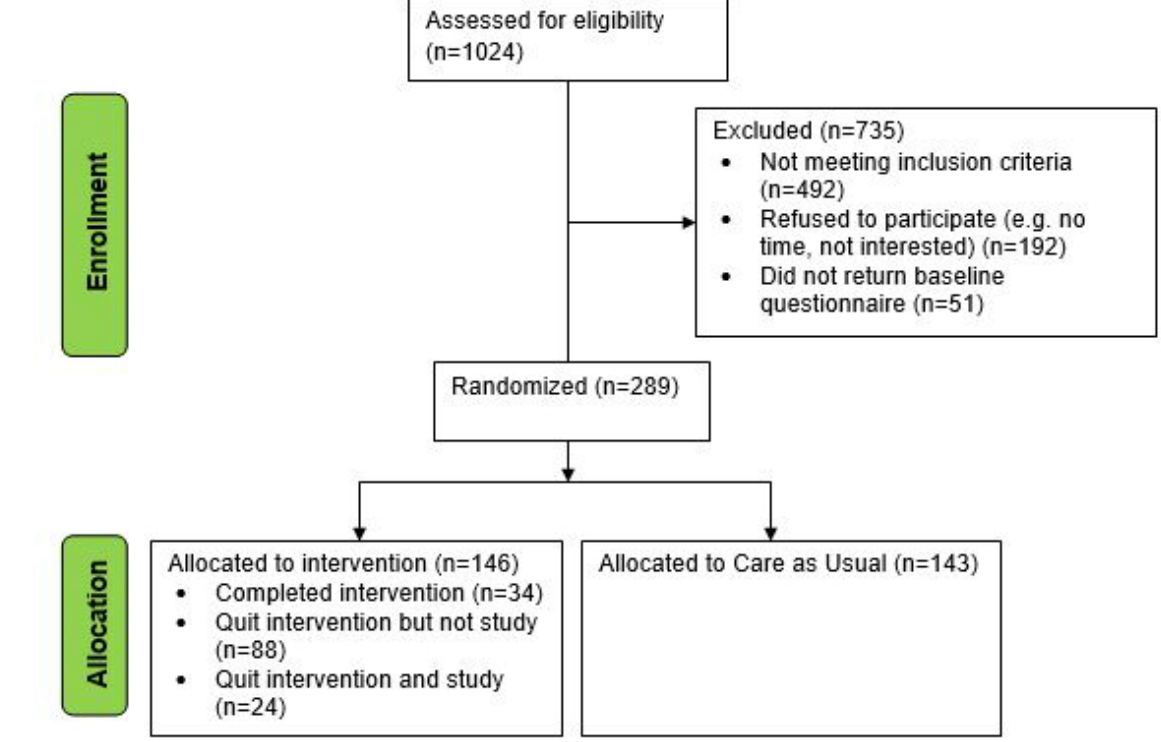
Figure 1. Flowchart of patient